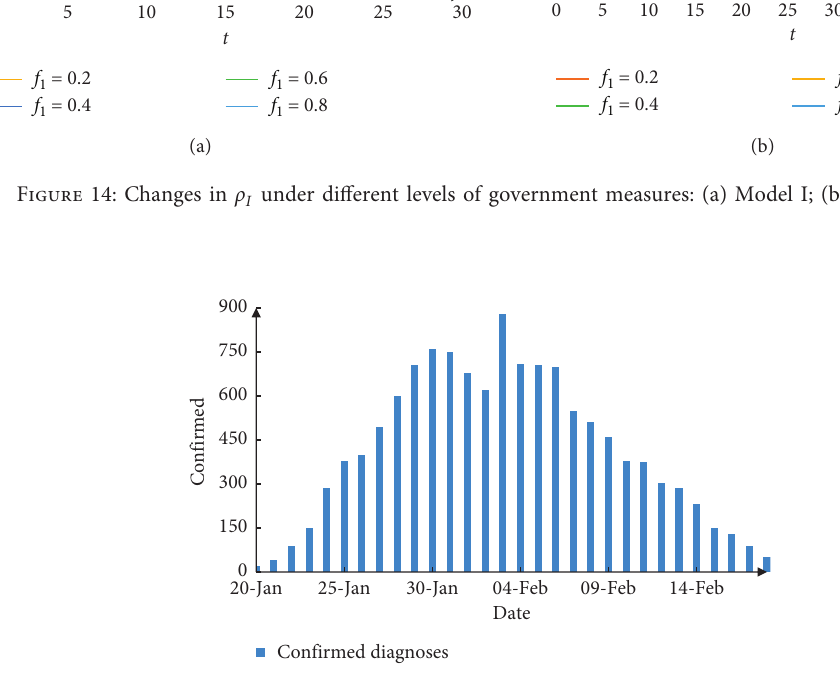
Figure 15: The number of newly confirmed diagnoses in regions outside